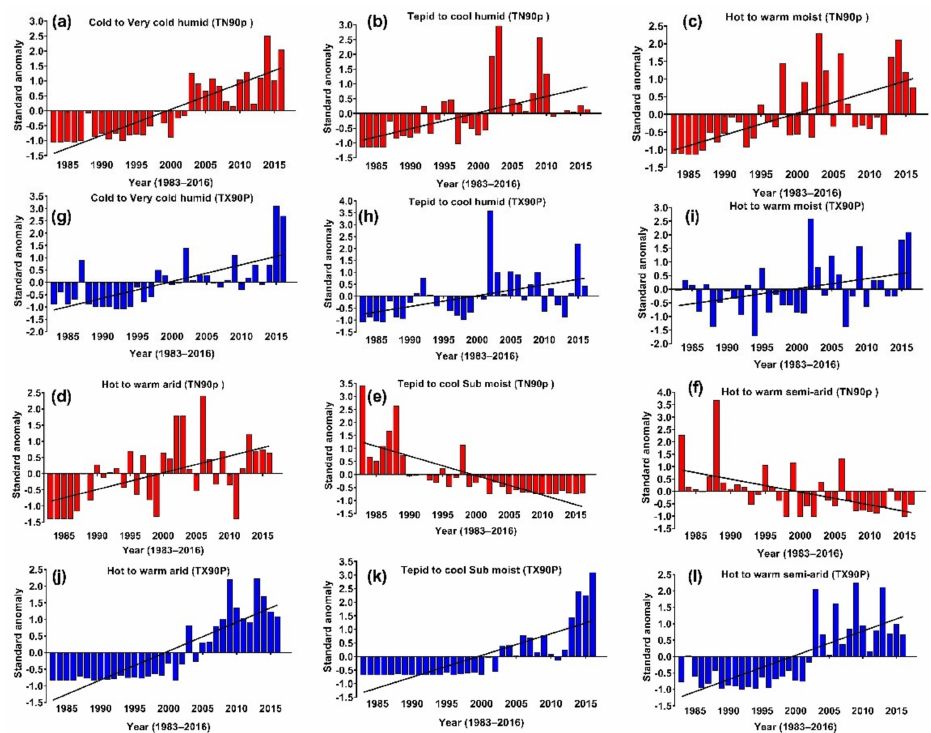
Figure 5. Warm nights (TN90p) ( a – f ) and warm days (TX90p) ( g – l ) over agroecological zones for the period